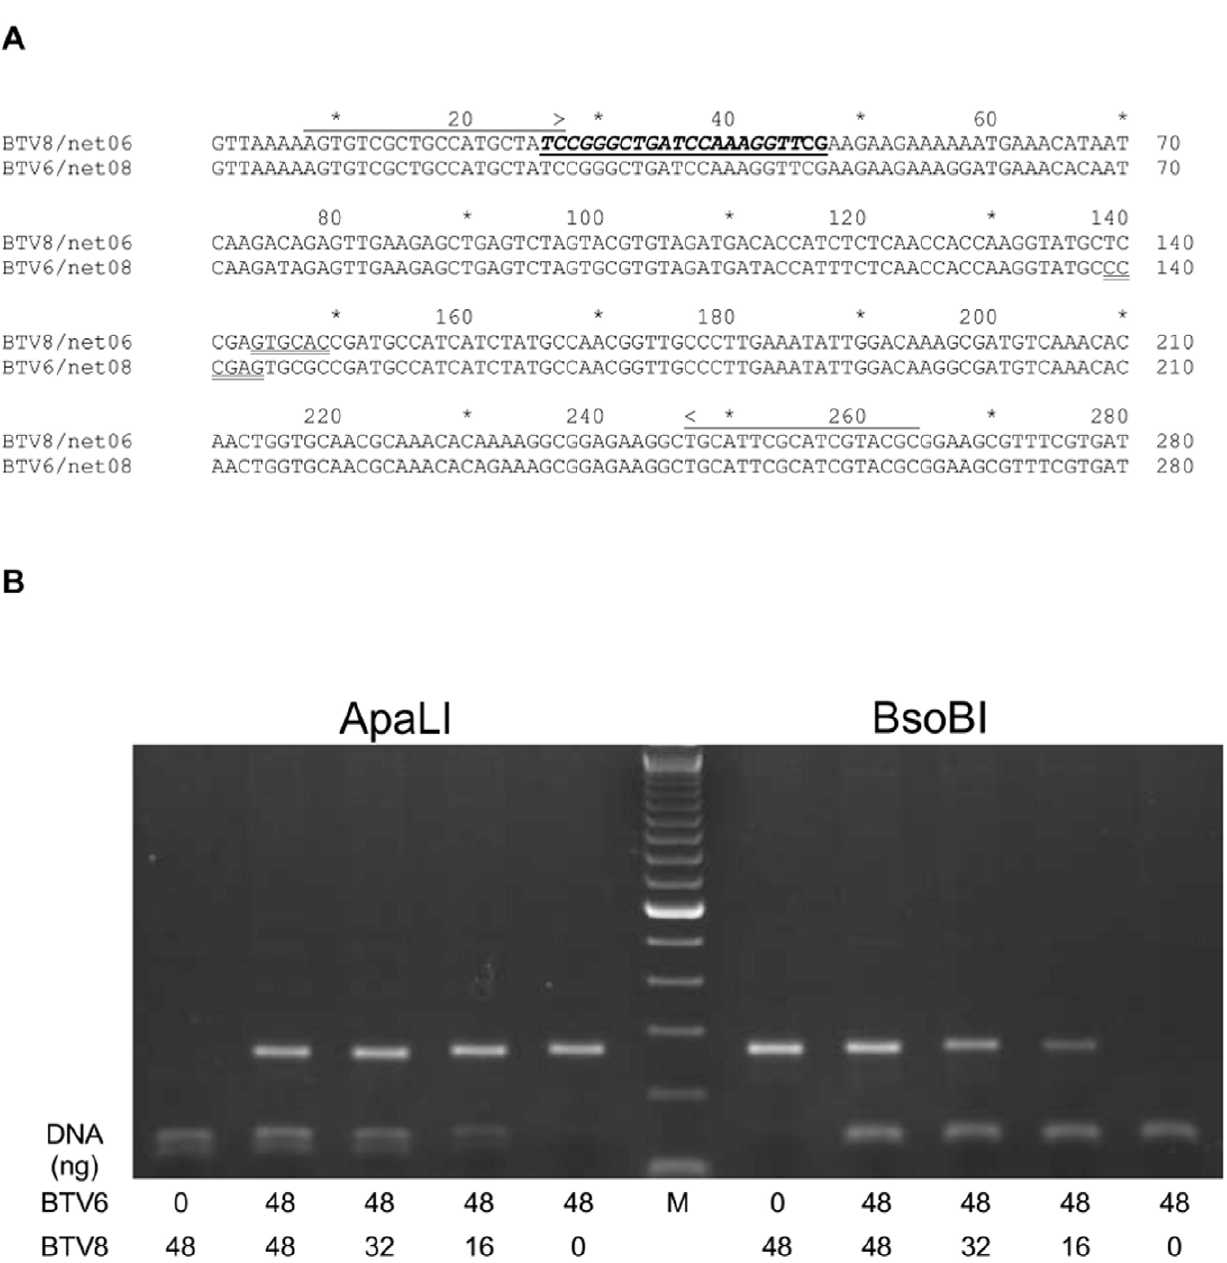
Figure. 1. S10-genotyping by restriction analysis. (A) Sequence comparison of Seg-10 amplicons of BTVac-6 and BTV8/net07. Positions and orientations of primers and probe (bold, italics, underlined) are indicated by arrows [23]. The unique restriction sites of Bso BI (CYCGRG) en Apa LI (GTGCAC) are double underlined. (B) Mixing experiment of different amounts (ng) of Seg-10 amplicon from BTV6- or BTV8 digested with Bso BI or Apa LI and analysed by electrophoresis on a 1,5% agarose